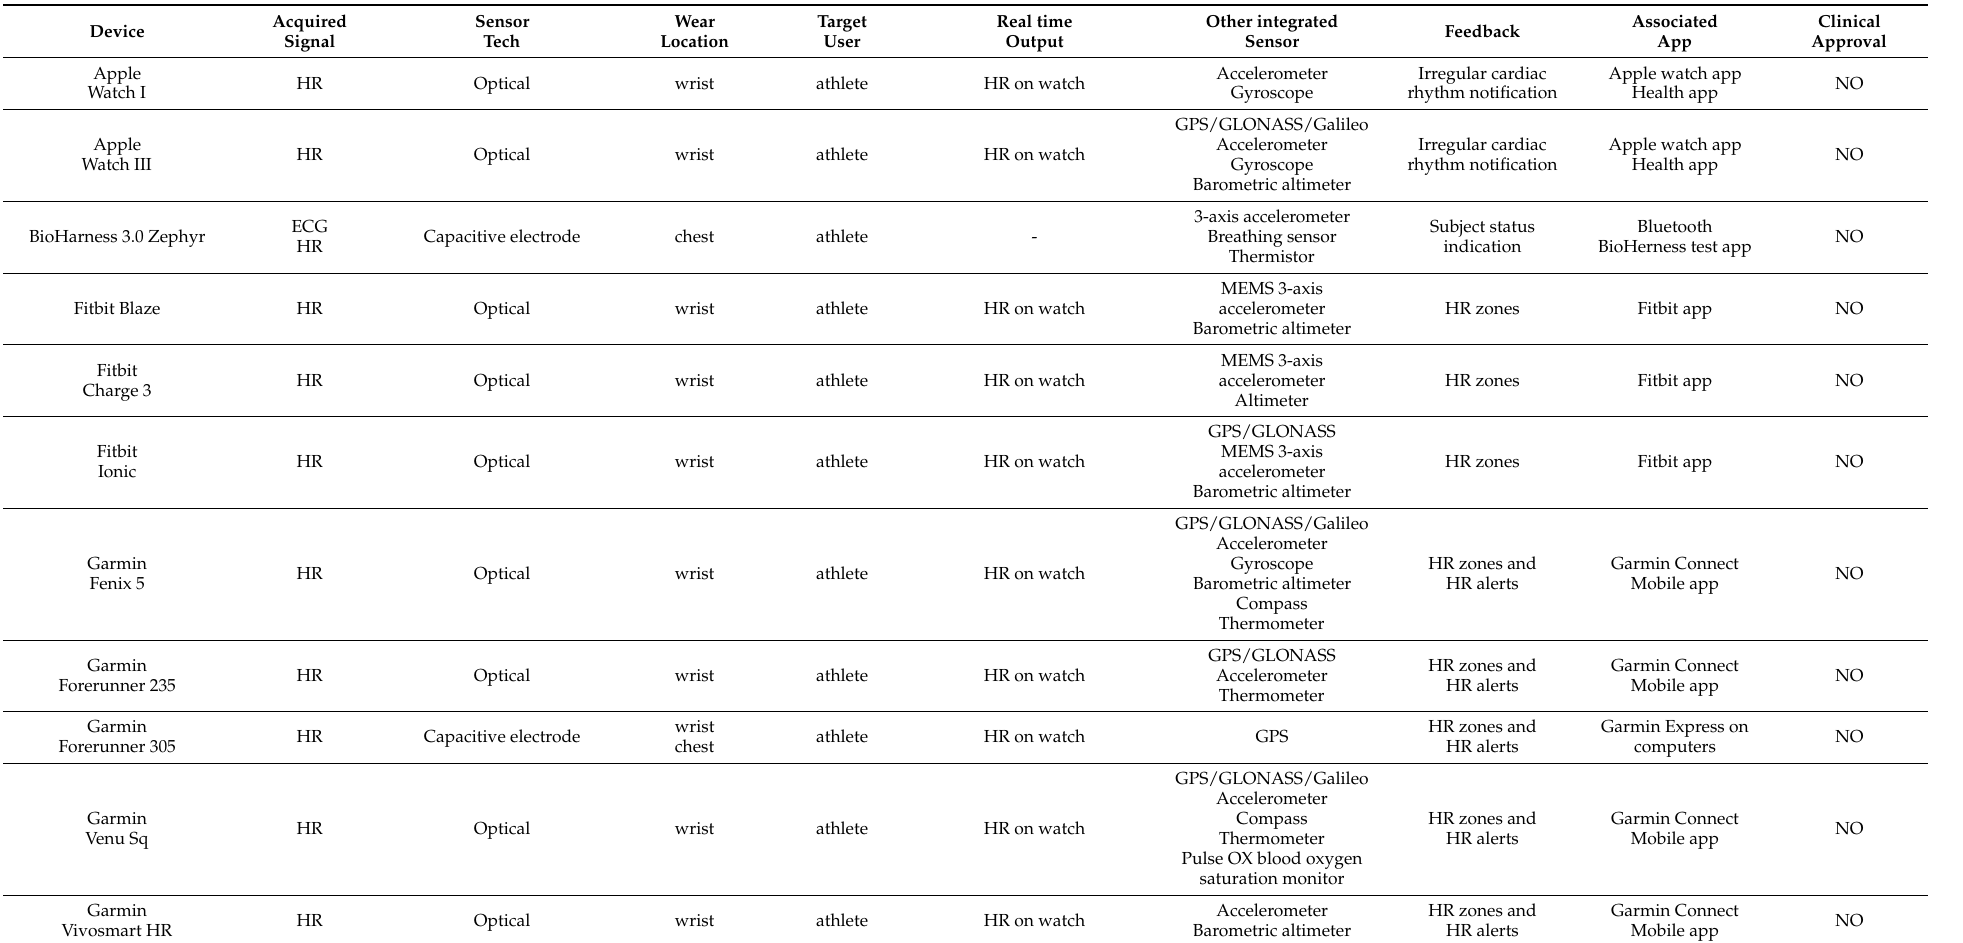
Table 4. Commercial wearable and portable devices characterized by acquired signal (ECG and/or HR), sensor tech, wear location, target user, real-time output, other integrated sensor, feedback, associated app, clinical approval. Information not available is reported as